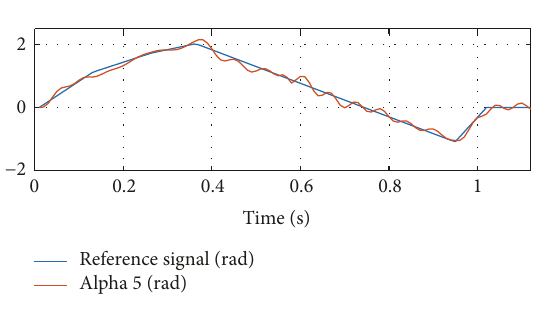
Figure 24: Trajectory of 𝛼 5